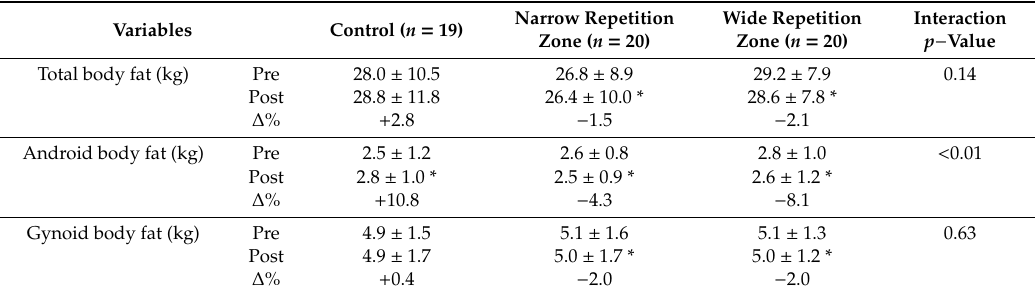
Table 1. Body fat at pre- and post-intervention according to